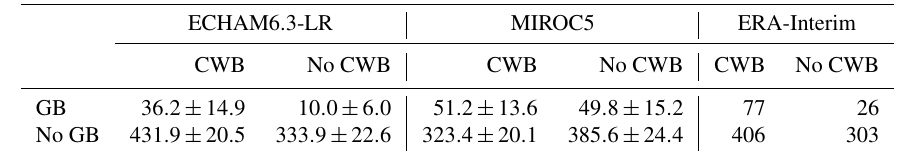
Table 2. Ensemble mean and spread (standard deviation over the members) of the number of days in each category for ECHAM6.3-LR and MIROC5 and total number of days in each category for ERA-Interim. Unit: days. The CWB/no CWB categories distinguish the days for which the spatially averaged CWB frequency, as defined in Sect. 2.4, is greater than 0/equals 0. GB stands for Greenland blocking. The GB/no GB categories distinguish the blocked days from the non-blocked days, as defined in Sect. 2.3. The sum of the number of days in the four categories for each model and ERA-Interim equals the total number of winter (DJF) days in the decade